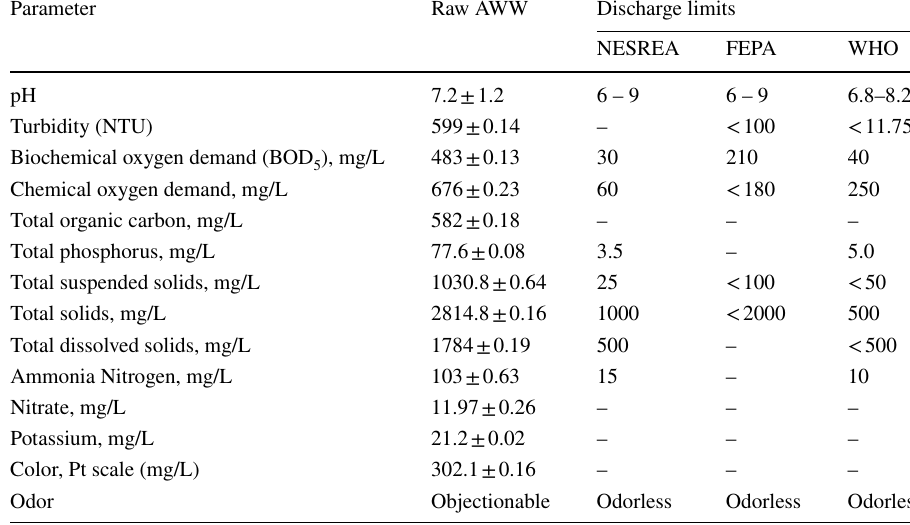
Table 4 The physicochemical characteristics of AWW